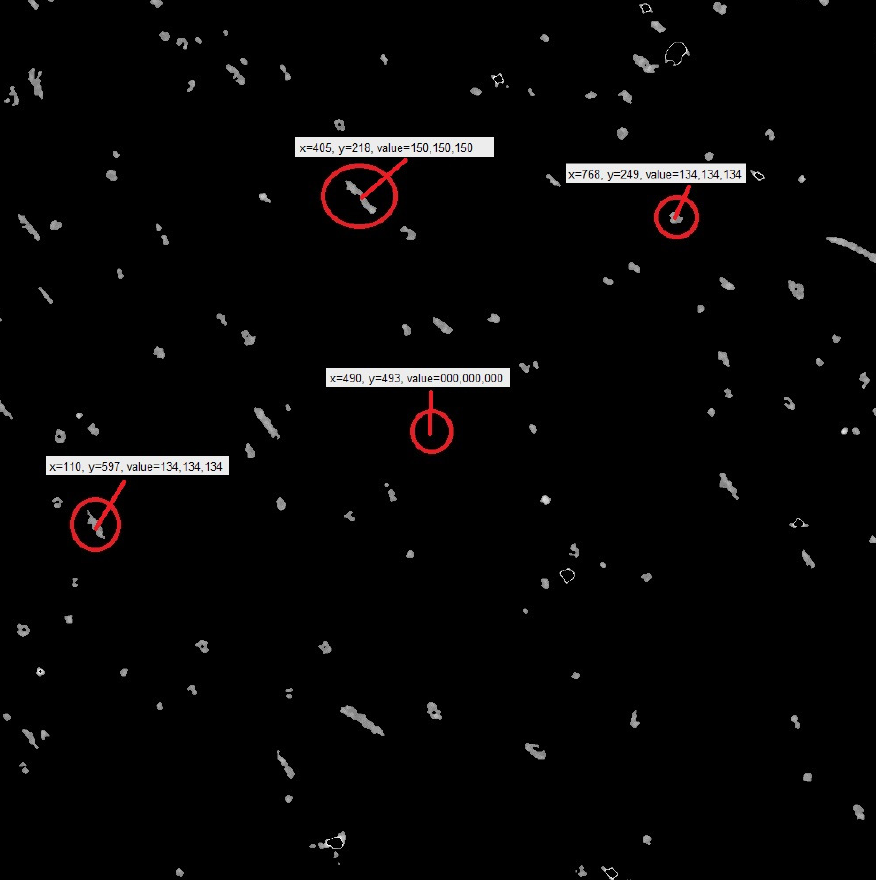
Figure 6. Slice image of a polyester-short-fiber-reinforced rubber composite sample after binarization treatment (image 39).